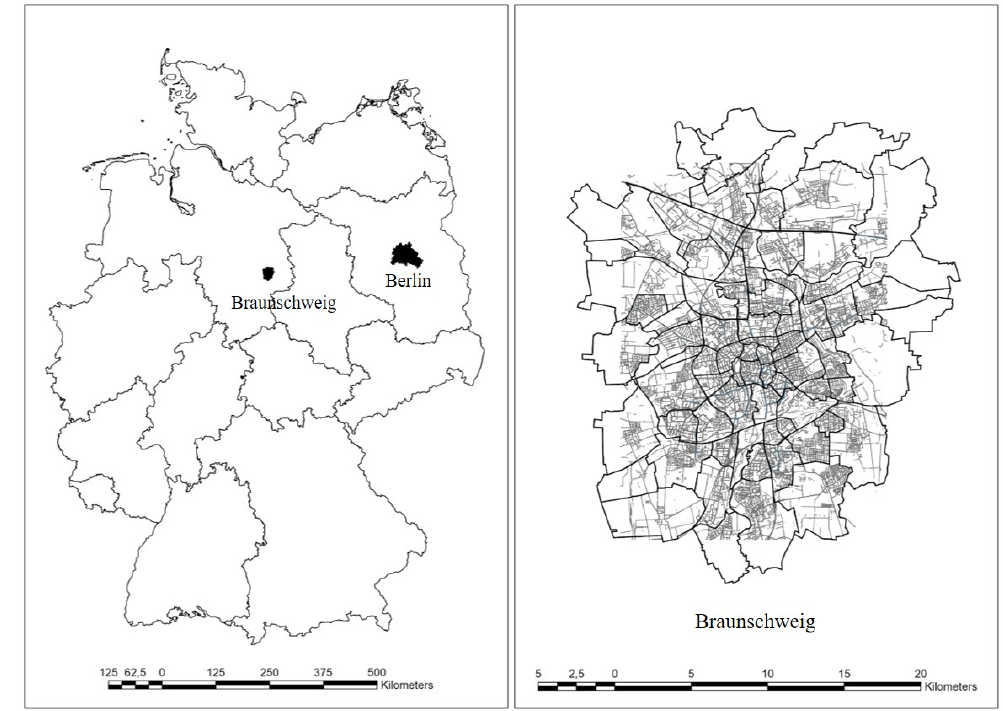
Figure 3. Map showing the location of the city of Braunschweig.